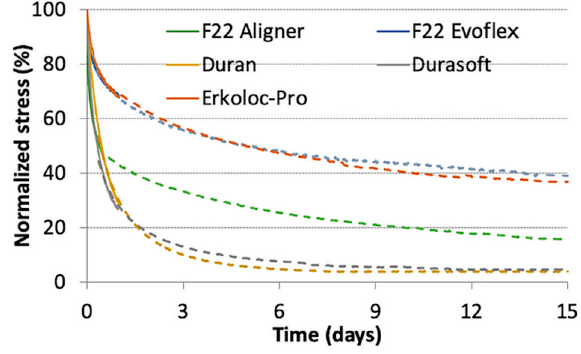
Table 4. Normalized stress relaxation (means).